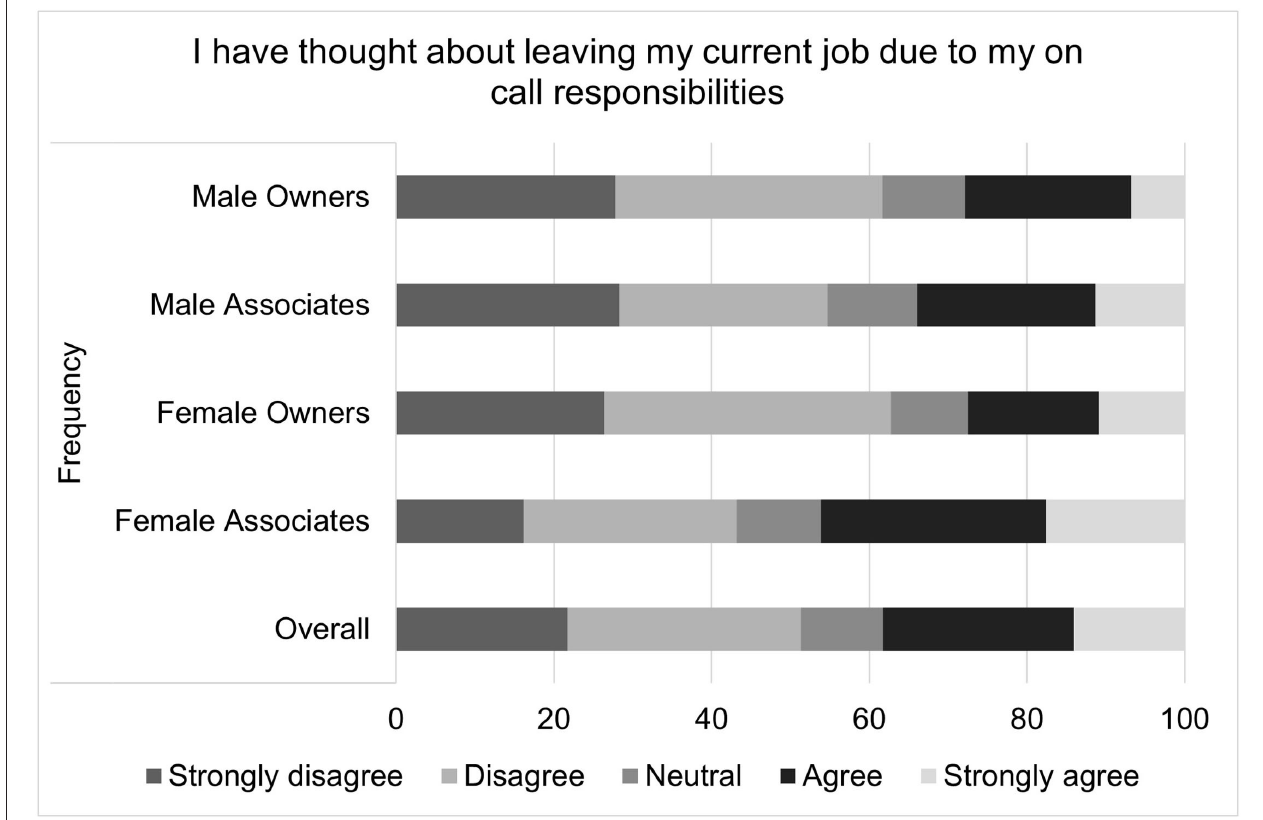
FIGURE 2 | Impact of on-call duties on job satisfaction, as reported by male and female practice owners and associate veterinarians.